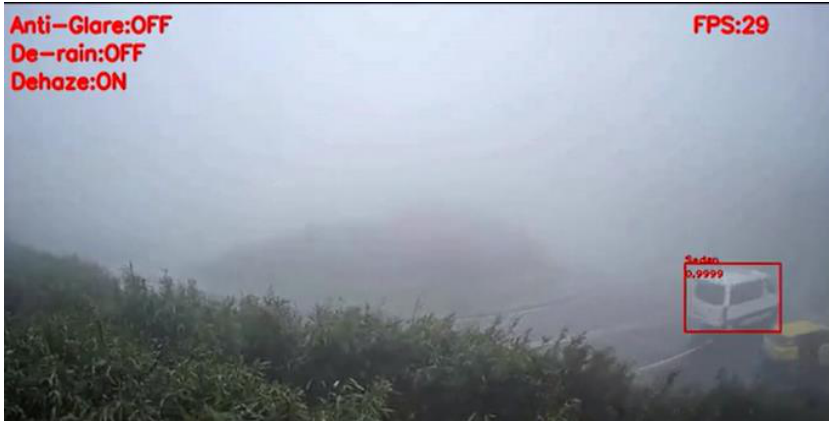
Figure 29. Haze scene image frame detected by our proposed system.